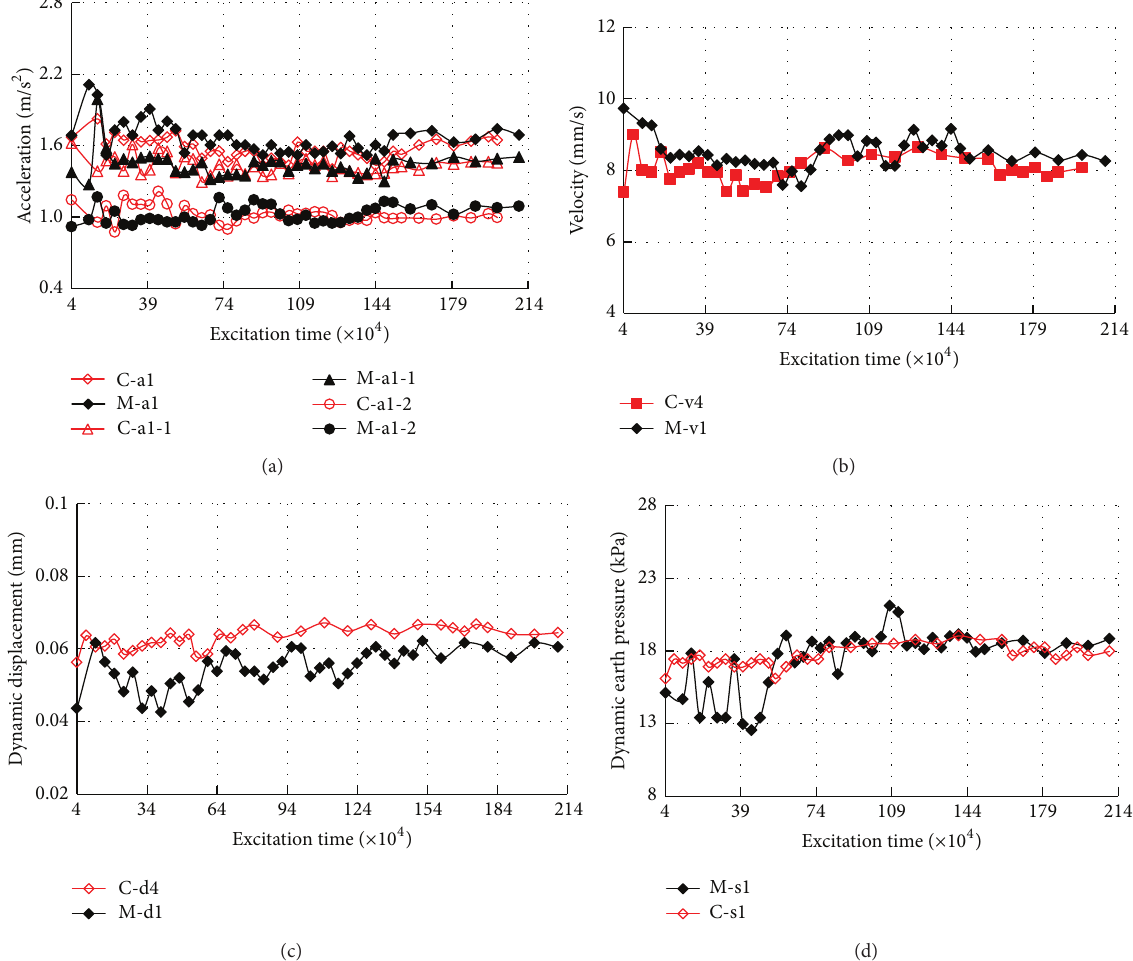
Figure 14: Vibration response of the low subgrade versus vibration times: vertical acceleration (a), vertical velocity (b), dynamic displacement (c), and dynamic soil pressure (d) of the low subgrade versus vibration